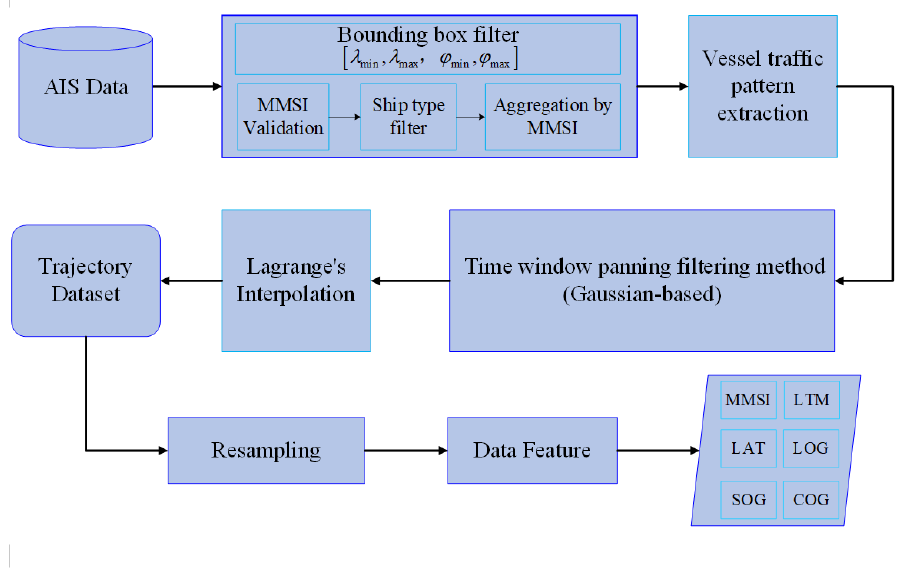
Figure 5. Data Processing Flow Chart.